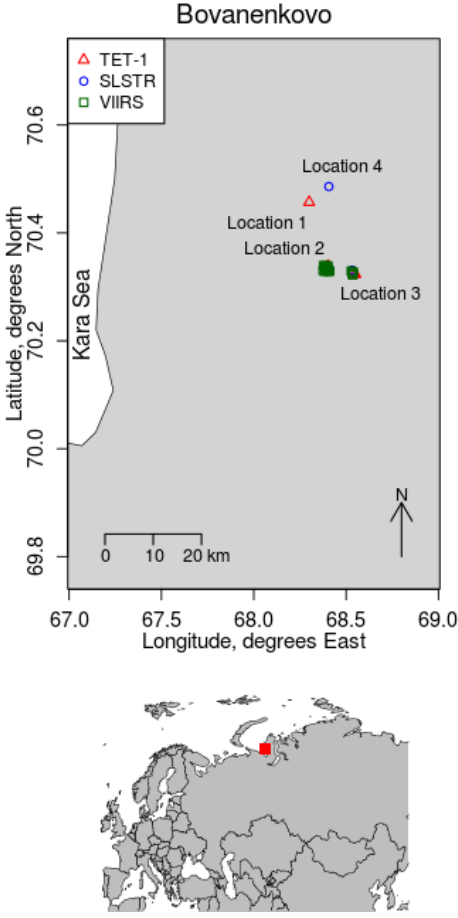
Figure 15. Location of the detections in the Bovanenkovo area between 15 December 2016 and 2 January 2017 ( upper ) and location of Bovanenkovo in Eurasia ( lower ).